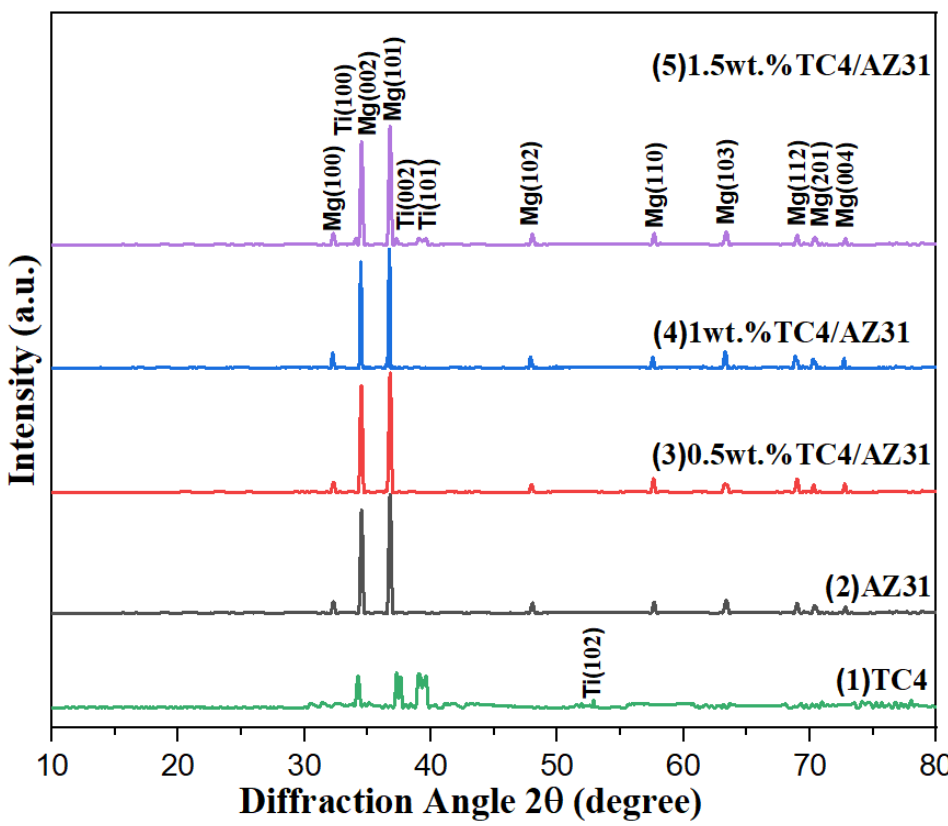
Figure 6. XRD patterns of composites.